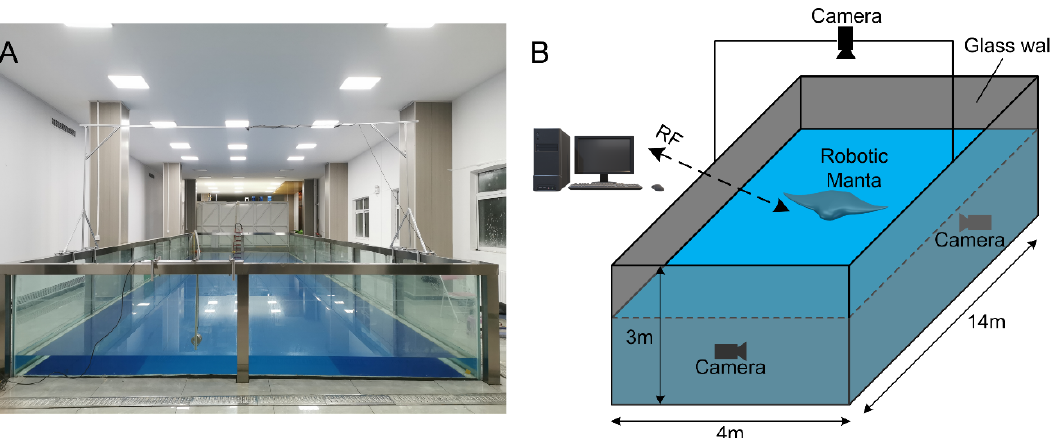
Figure 7. The transparent water pool. ( A ) The actual view of the pool. ( B ) The composition of the experimental